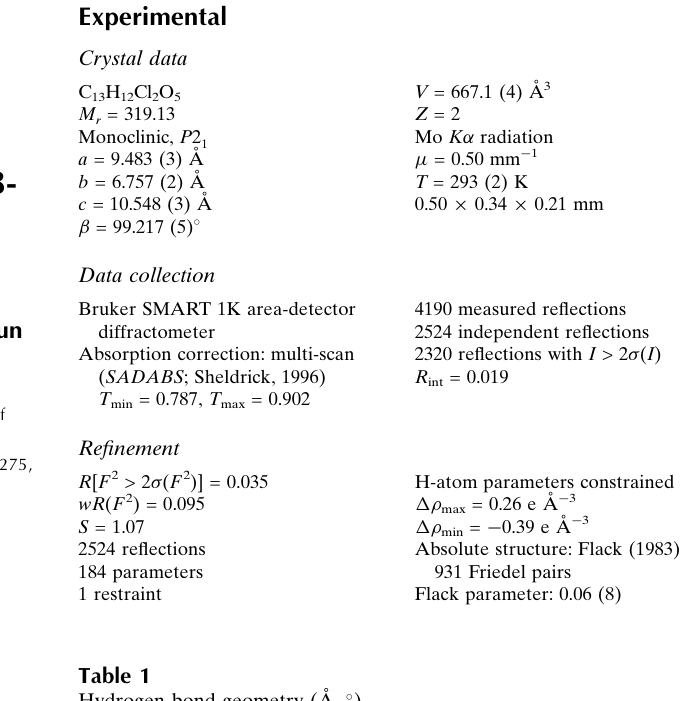
Hydrogen-bond geometry (A˚ , (cid:2)